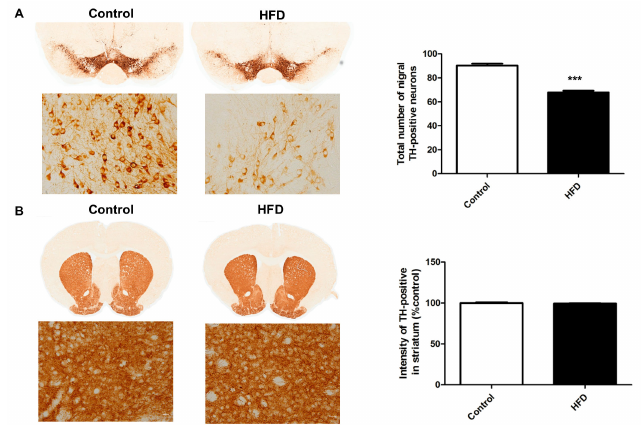
Figure 3. Tyrosine hydroxylase (TH) immunostaining of dopaminergic neurons in the substantia nigra (SN) and striatum. The TH-positive area was measured using ImageJ software. ( A ) HFD mice had fewer TH-positive cells in the SN compared to the controls. Upper panels, magnification 20 × ; lower panels, magnification 600 × . ( B ) The TH-immunoreactive fiber density in the striatum was not altered between HFD and control mice. Upper panels, magnification 10 × ; lower panels, magnification 600 × . The asterisks represent the level of statistical significance calculated using a two-tailed Student’s t -test (*** p < 0.001); data are represented as mean ± SEM ( n = 10 in each group). TH: tyrosine hydroxylase; SN: substantia